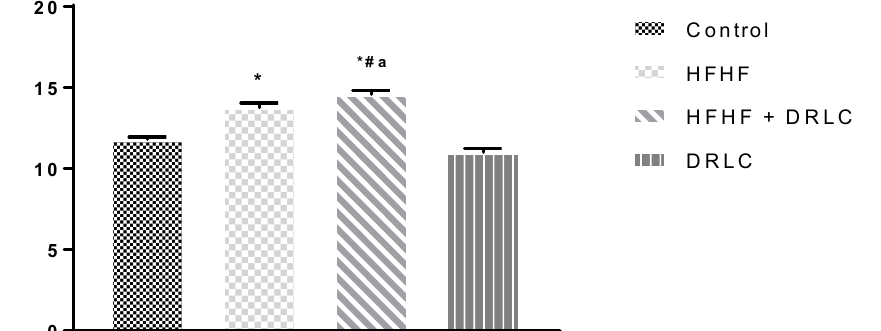
Figure 1. Serum Uric acid. n = 5. Values were expressed as Mean ± SEM, * significantly different from control ( p < 0.05); # significantly different from HFHF ( p < 0.05); a significantly different from HFHF + DRLC ( p < 0.05). NB: Control, HFHF (high fructose high fat), HFHF + DRLC (D-ribose-L-cysteine) and DRLC in Wistar rats after 8 weeks of DRLC